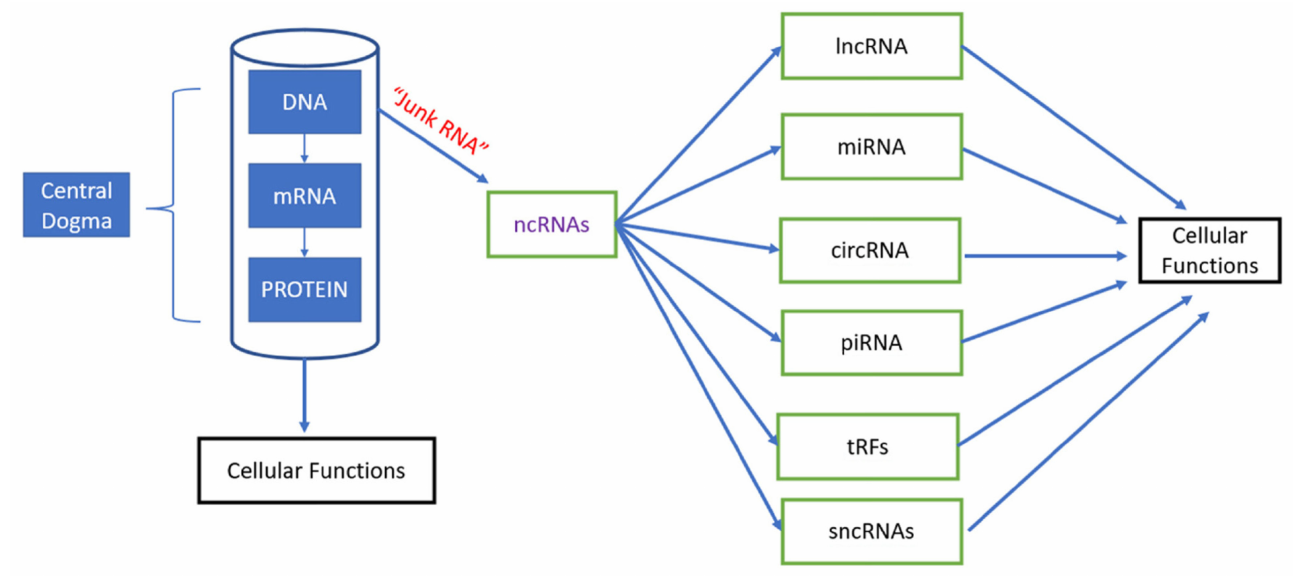
Figure 1. From the Central Dogma to ncRNAs production in regulating cellular functions. Originally, it had been postulated as the “central dogma” that there is a flow of information that is passed from DNA in the nucleus, transcribed into messenger RNA (mRNA) which travels outside the nucleus of the cells into the cytoplasm where it is translated into proteins. Proteins are the building blocks of cells and are crucial for cellular functions. The DNA that was transcribed into non-coding RNA (ncRNA) was considered as ”junk RNA”. However, in the past decades this concept has been revolutionized with the discovery of the critical roles of ncRNAs (such as long non-coding RNA [lncRNA], microRNA [miRNA], circulatory RNA [circRNA], PIWI-interacting RNA [piRNA], tRNA-derived fragments [tRFs], small ncRNA [sncRNAs]) in regulating cellular functions and their implications in medical conditions, such as breast